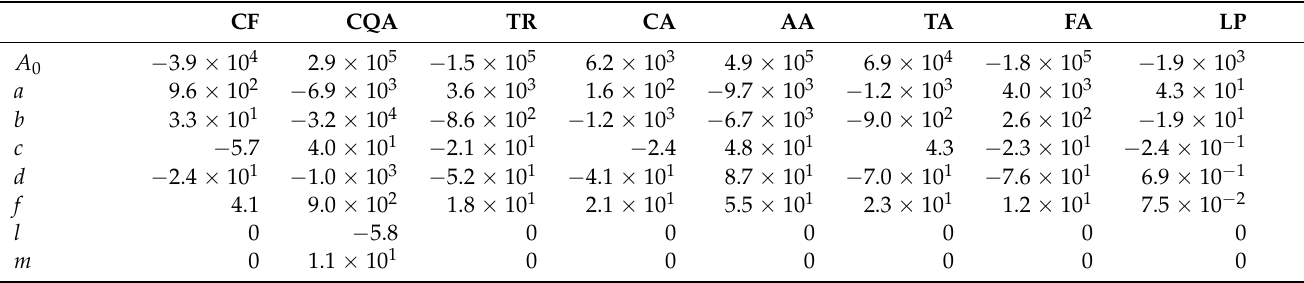
Table A6. Coefficients of the dissolution rate α r , v granulometry r = F and Robusta variety v =